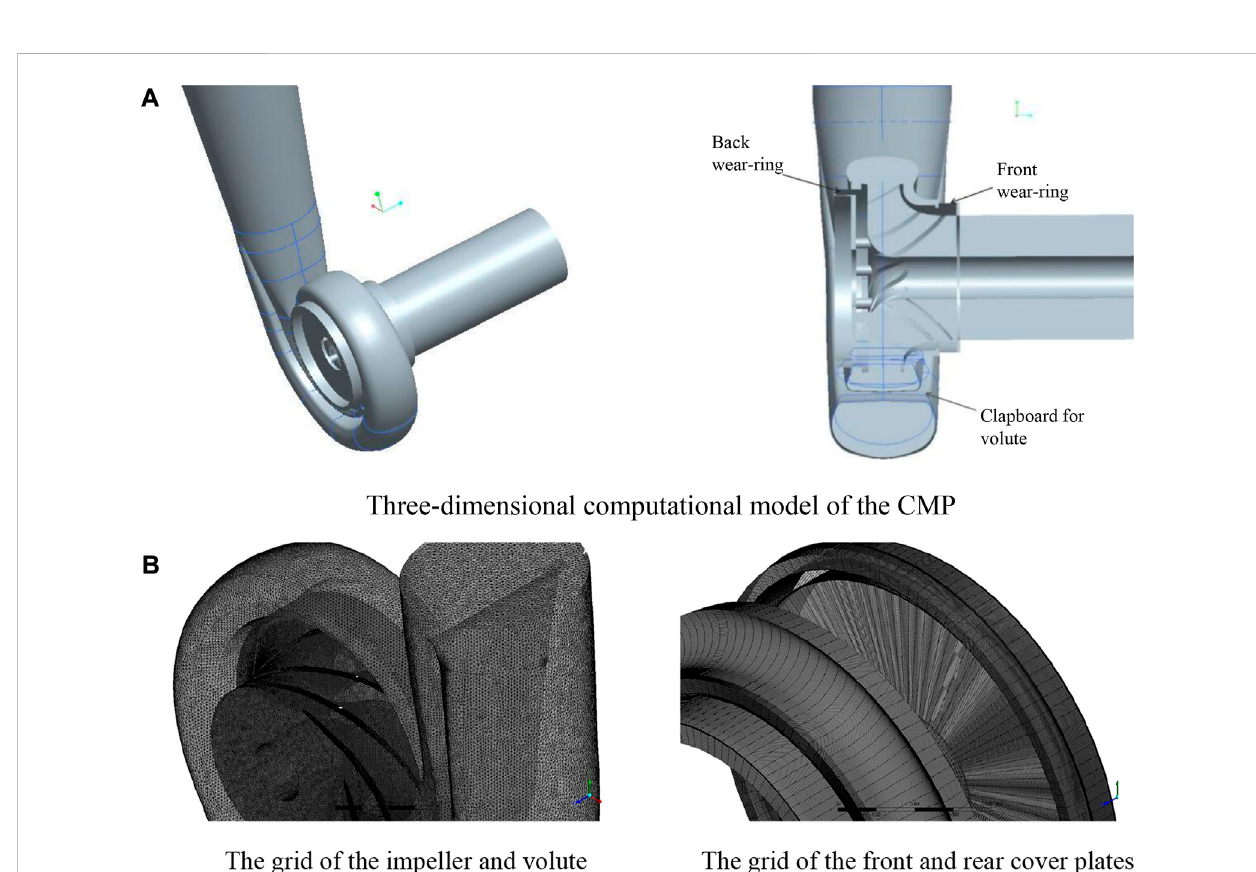
FIGURE 1 Three-dimensionalcomputationalmodel andgrid oftheCMP. (A) Three-dimensional computational modeloftheCMP. (B) Thegrid oftheimpeller and volute and the grid of the front and rear cover